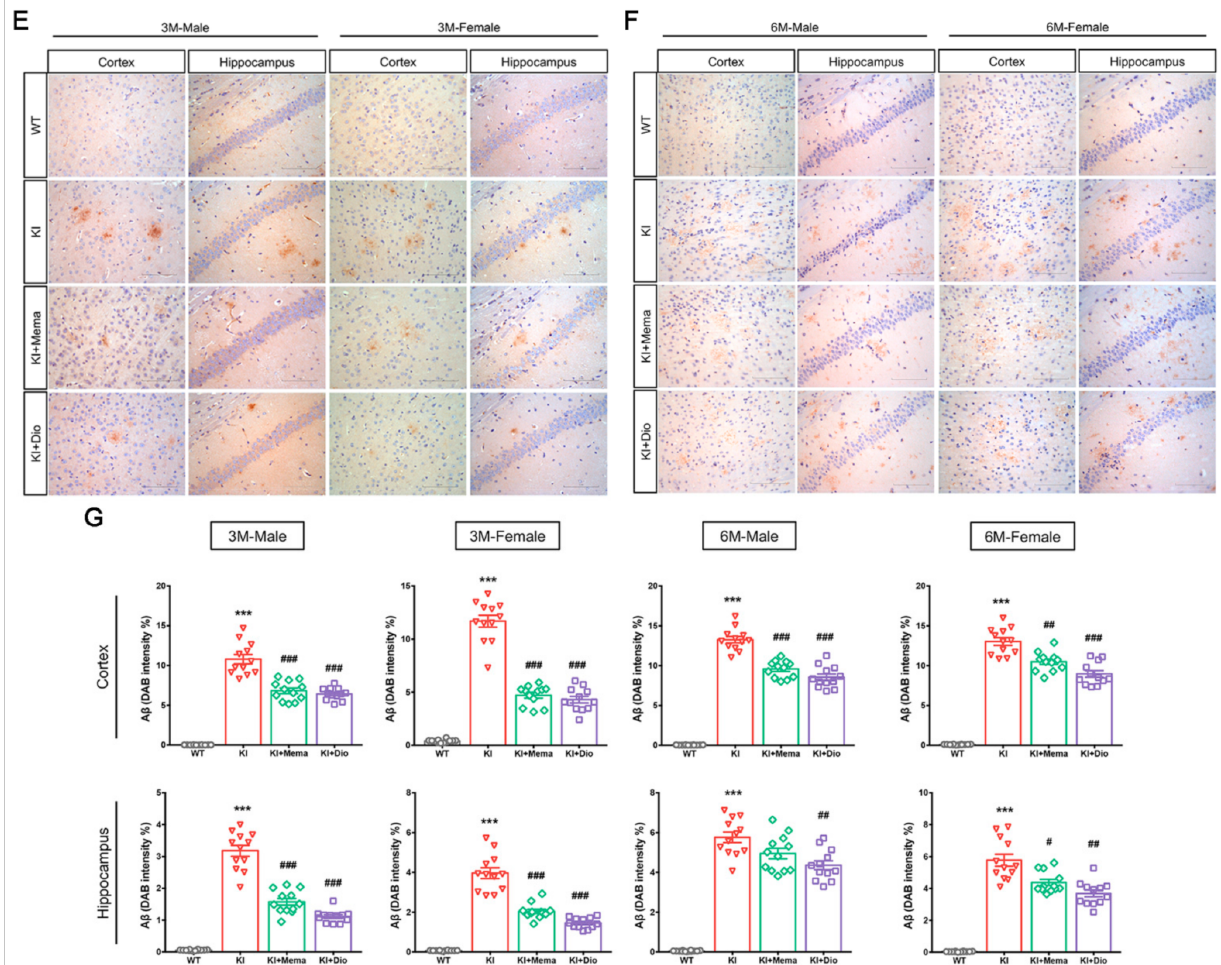
Figure 2. Effect of Dio on abnormal accumulation of A β in young adult App NL-G-F mice. ( A – D ) Western blotting and quantification of App, BACE, and A β protein expression in the cortex and hippocampus of 3- and 6-month-old male and female WT or App NL-G-F mice. Data are expressed as mean ± SEM. n = 6 mice/group. * p < 0.05 compared with WT; ** p < 0.01 compared with WT; *** p < 0.001 compared with WT. # p < 0.05 compared with App NL-G-F ; ## p < 0.01 compared with App NL-G-F ; ( E – G ) Images and quantification showing the A β plaque staining in the cortex and hippocampal CA1 region in male and female WT and App NL-G-F mice at 3 and 6 months of age. Scale bar: 0.1 mm. Data are expressed as the mean ± SEM. n = 3 slides/group. Four randomly selected fields of view for each section under the microscope. *** p < 0.001 compared with WT. # p < 0.05 compared with App NL-G-F ; ## p < 0.01 compared with App NL-G-F ; ### p < 0.001 compared with App NL-G-F